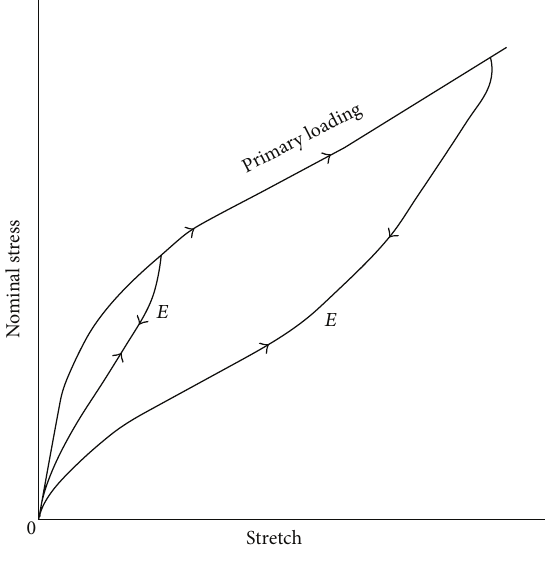
Figure 1: Schematic loading-unloading curves in simple tension (Mullins